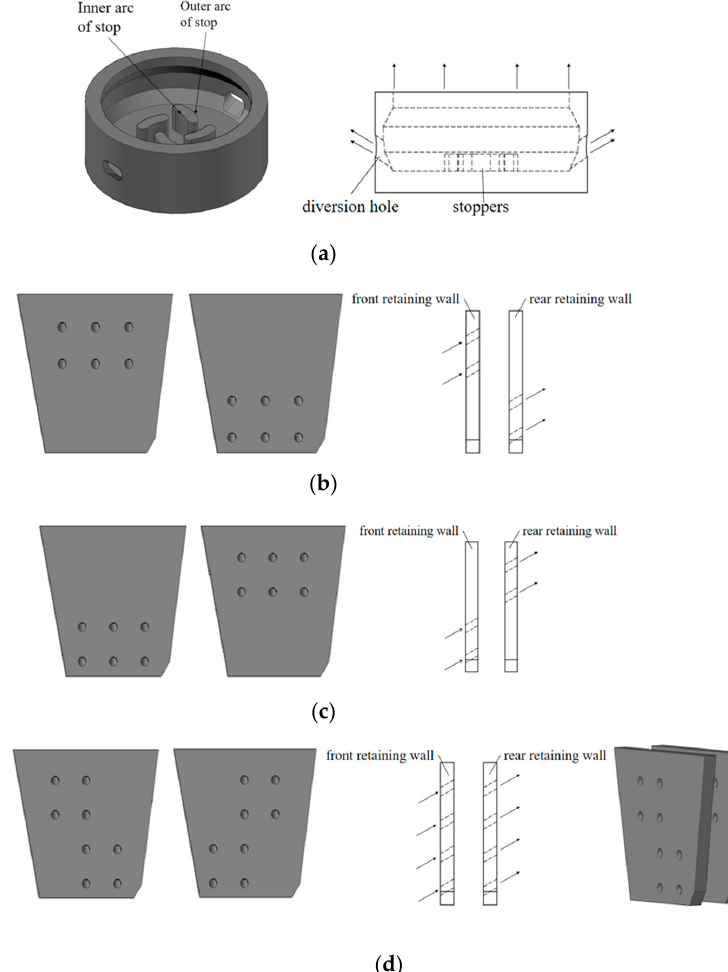
Figure 2. SCB mode structure chart. ( a ) IRS mode; ( b ) TIBO mode; ( c ) BITO mode; and ( d ) X mode. Table 1. SCB model structure parameters.